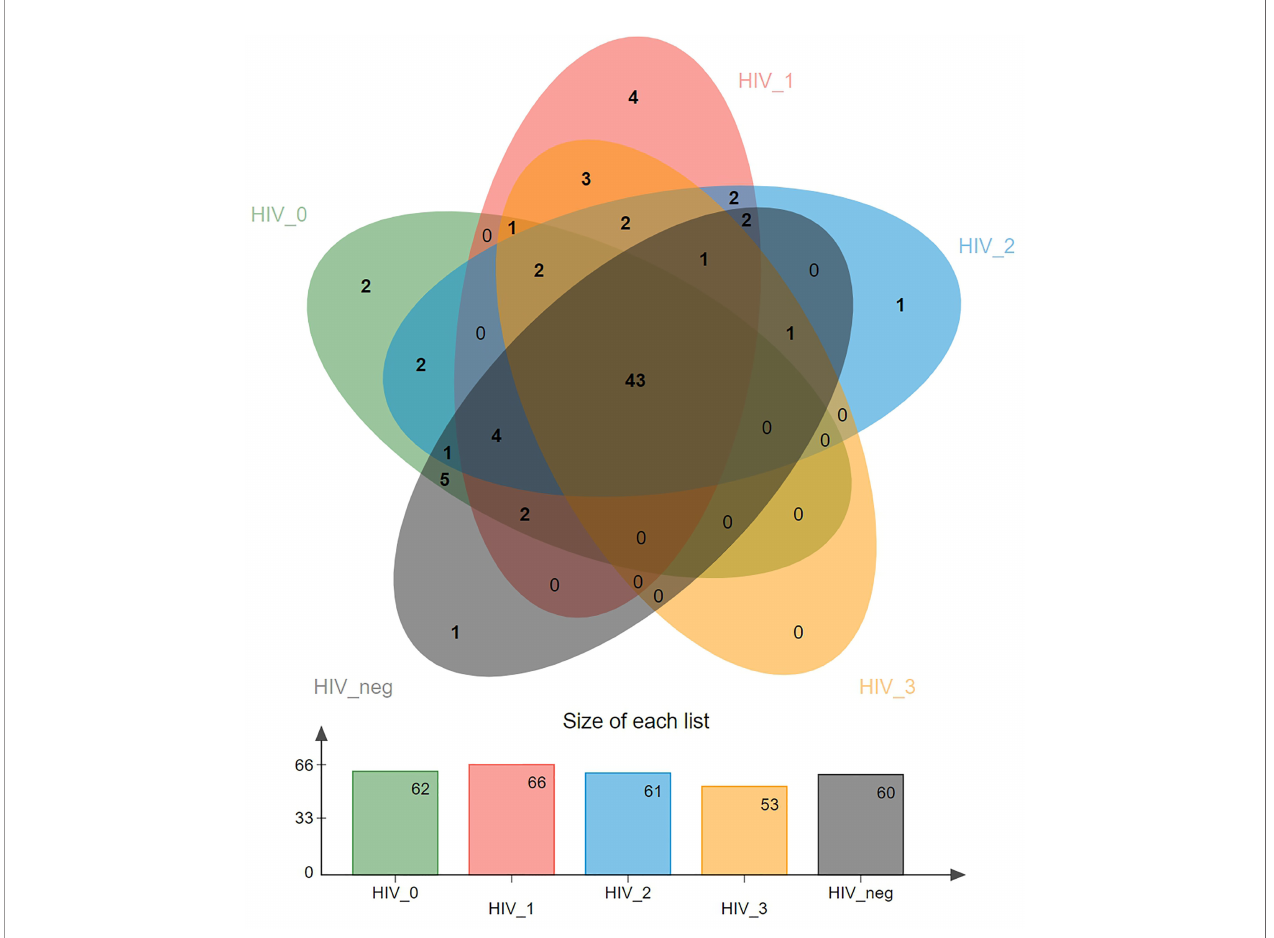
FIGURE 1 | Venn diagram of the distribution of salivary viral genera in the fi ve groups. Overlapping parts represent shared species, and non-overlapping parts represent unique species. The bar graph shows the total number of species in each